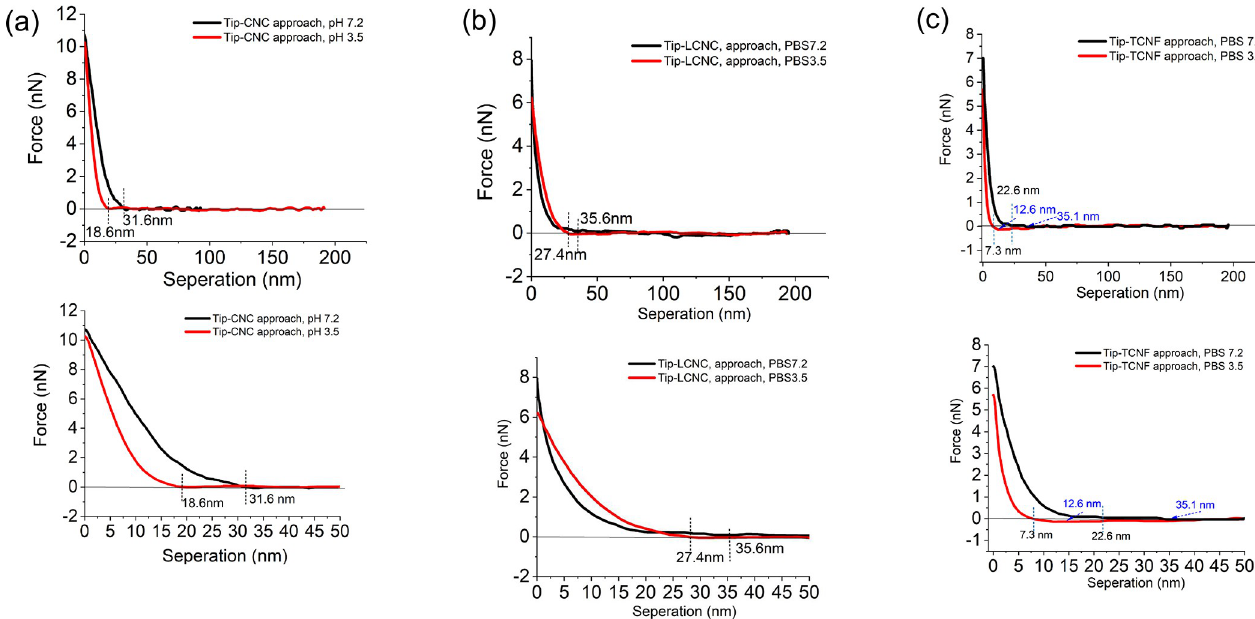
Fig 6. Representative force-distance approach curves recorded at a single (a) CNC, (b) LCNC, and (c) TCNF fibre measured at pH 3.5 and